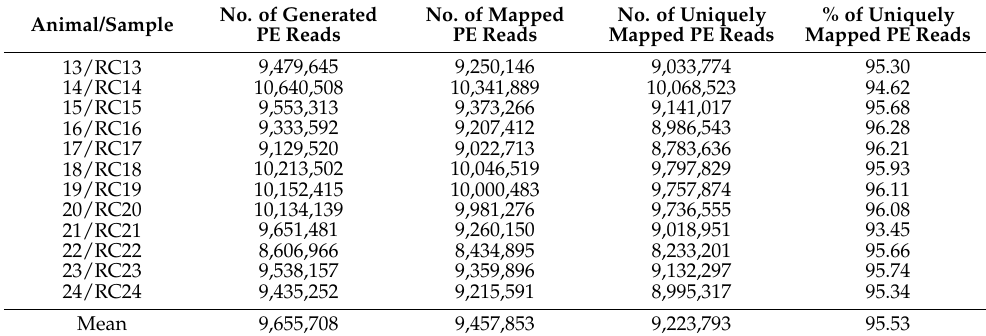
Table 4. Total number of generated PE reads aligned to the reference genome, and total number and percentage of uniquely mapped PE reads in samples collected from G2 animals (creep feeding) at weaning. Animal/Sample No. of Generated PE Reads No. of Mapped PE Reads No. of Uniquely Mapped PE Reads % of Uniquely Mapped PE